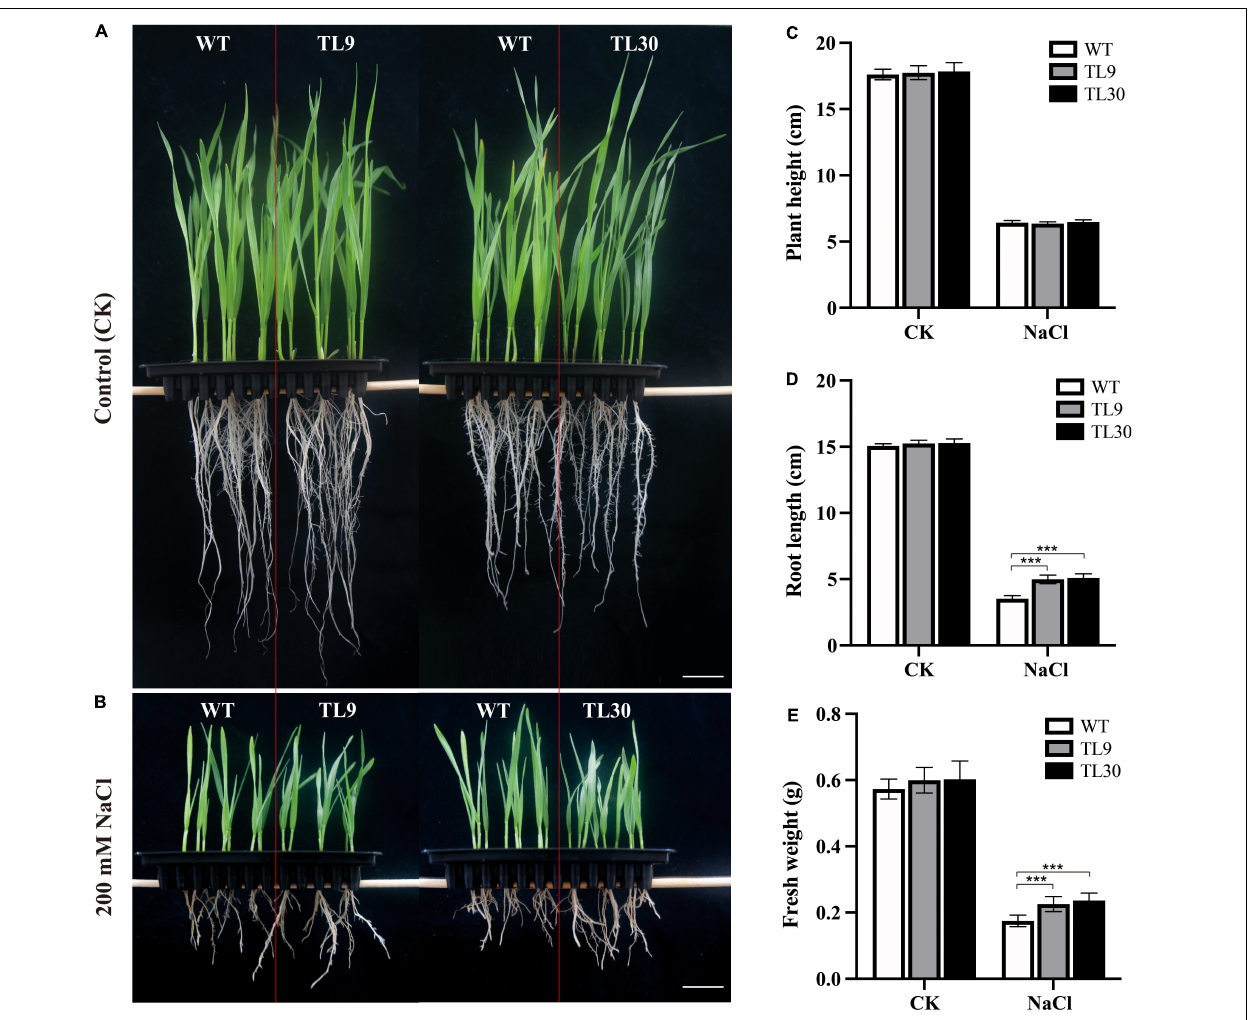
FIGURE 2 | Effect of EsMYB90 overexpression on the salt tolerance of the transgenic wheat. Two-day-old seedlings germinated on wet filter papers were transferred into 1/2 Hoagland solution, as a control group (A) , and transferred into 1/2 Hoagland solution containing 200 mM NaCl, as the treatment group (B) . The phenotypes of the wheat plants (TL9, TL30, WT) under the control (CK) and NaCl treatment (200 mM) were surveyed and photographed. Bar: 2 cm. Comparative analysis of root length (C) , plant height (D) , and fresh weight (E) among transgenic TL9, TL30, and WT line under 200 mM NaCl treatment and the normal growth condition. WT, wild type; TL9 and TL30, transgenic wheat lines. Mean values and deviations were calculated from three independent biological experiments. ***indicates p ≤